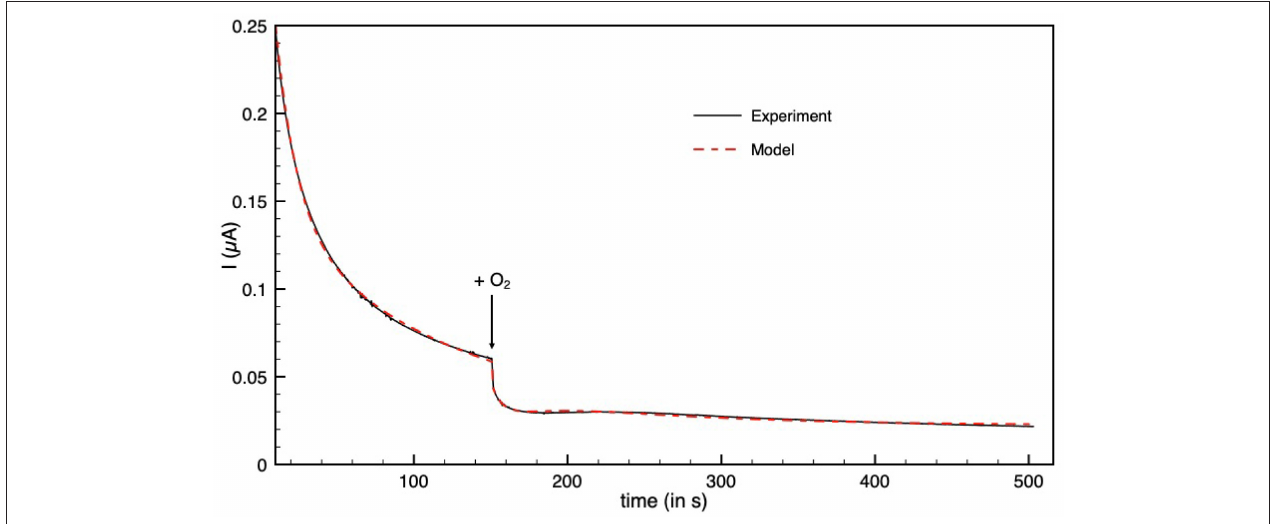
FIGURE 5 | Inactivation by O 2 of aerobically-purified Hnd hydrogenase adsorbed on PGE electrode. The black line corresponds to experimental data and the dashed red line is the best fit of the model in Equation (2). [O 2 ] = 48 µ M injected at t = 150s. E = +40 mV vs. SHE, T = 12 ◦ C, 1 bar H 2 , phosphate buffer pH 7, ω = 3,000